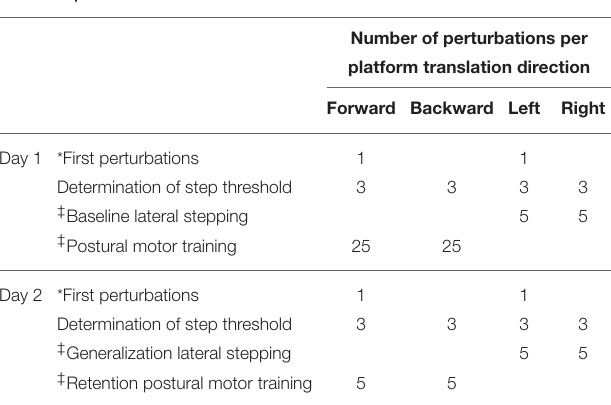
Number of perturbations per platform translation